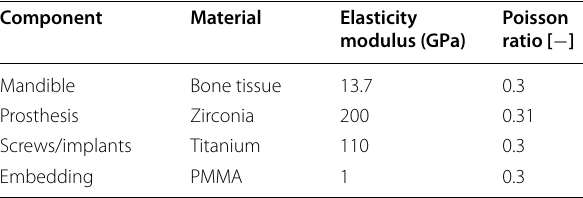
Table 2 Material parameters used for